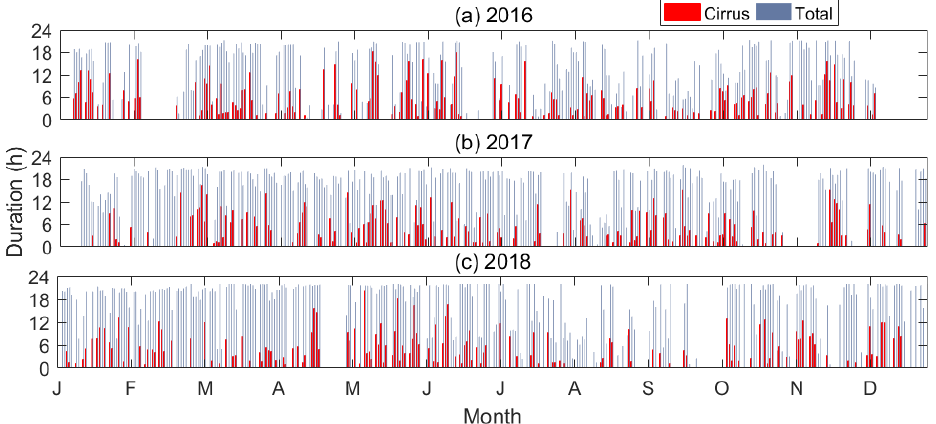
Figure 3. The day-to-day total duration of cirrus cloud (single-layer) occurrence and the total duration of MPL observations during (a) 2016, (b) 2017, and (c) 2018.